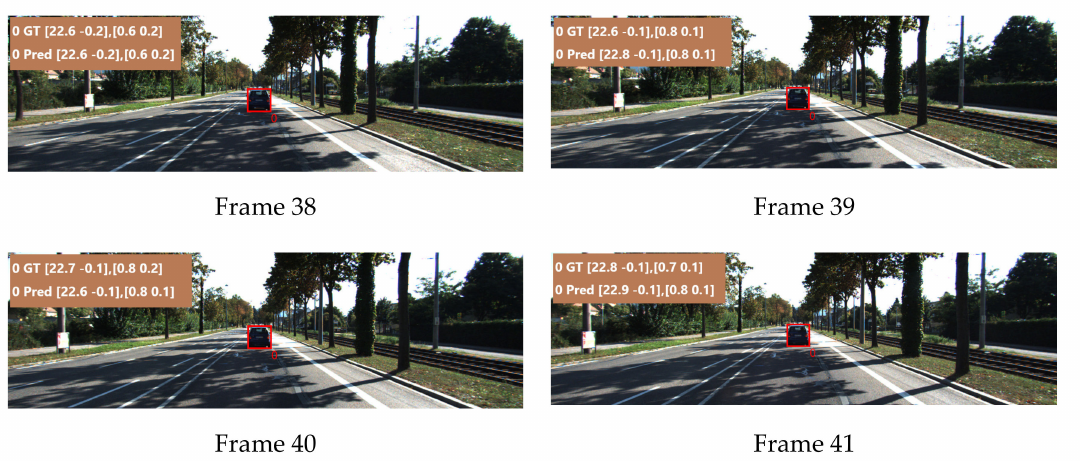
Figure 6. Prediction results of the target vehicle in the forward-following scenario. The green font represents the true values, which are the longitudinal lateral distance and longitudinal lateral velocity; the blue represents the predicted values, which are the longitudinal lateral distance and longitudinal lateral